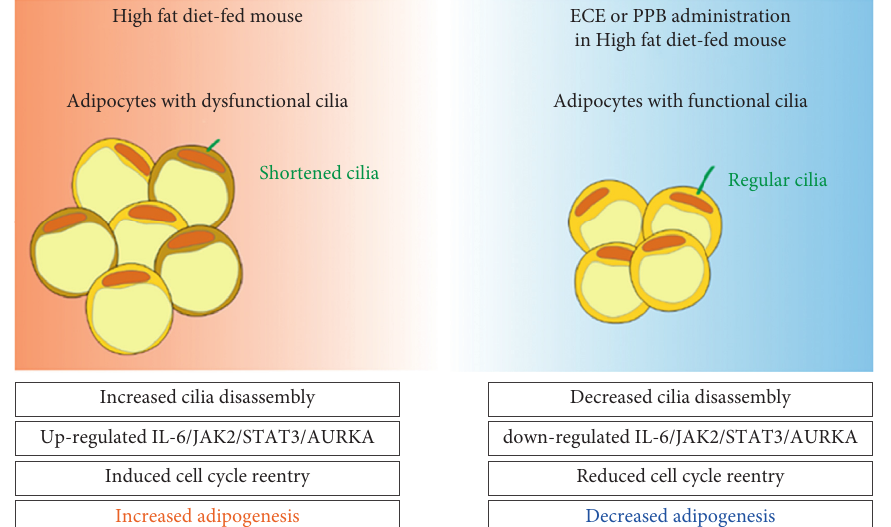
Figure 6: Graphical summary proposed scheme for the mechanism illustrating the regulation of primary cilia by ECE or PPB in a high-fat diet-fed